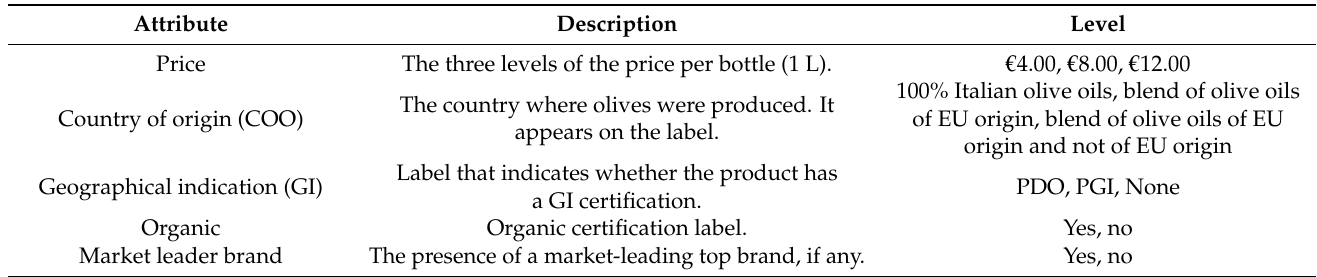
Table 1. Attributes and levels for olive oil in Italy.